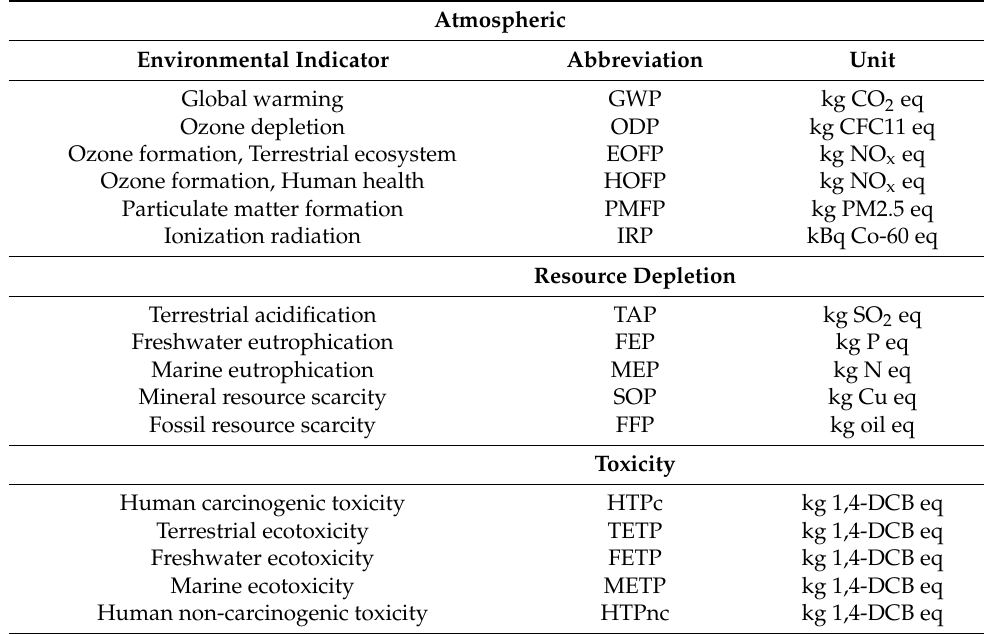
Table 2. The environmental impact indicators investigated (midpoint impacts categories).